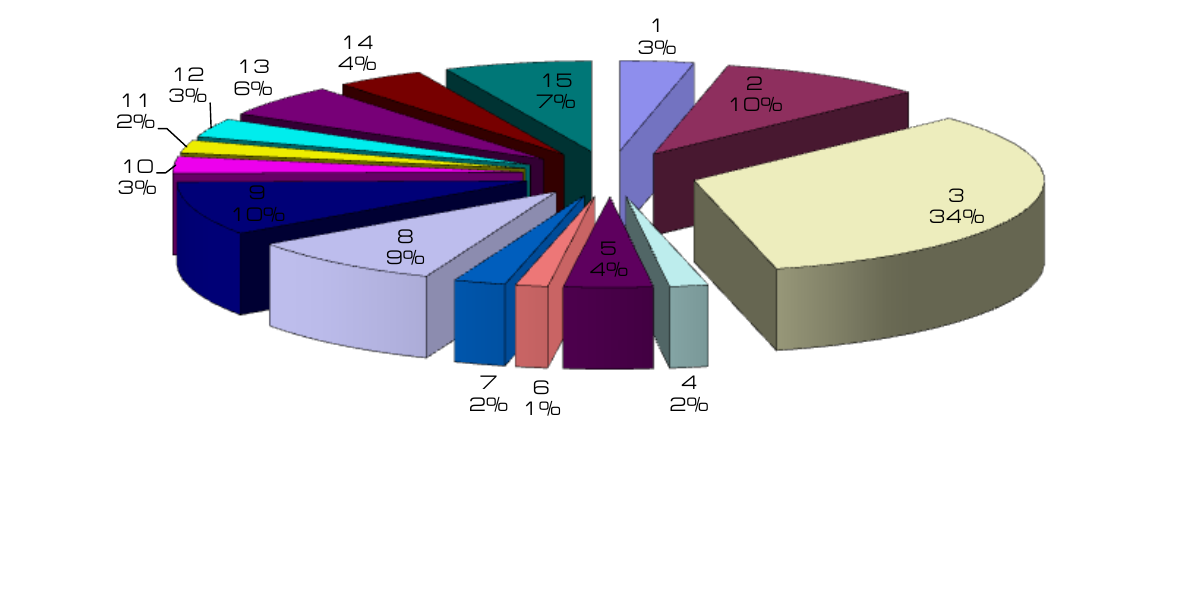
Fig.1. Diagram of significance of anatomic-morphological indicators for central